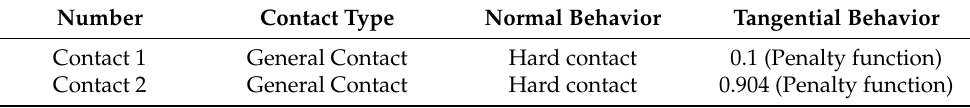
Figure 14. Finite element model.